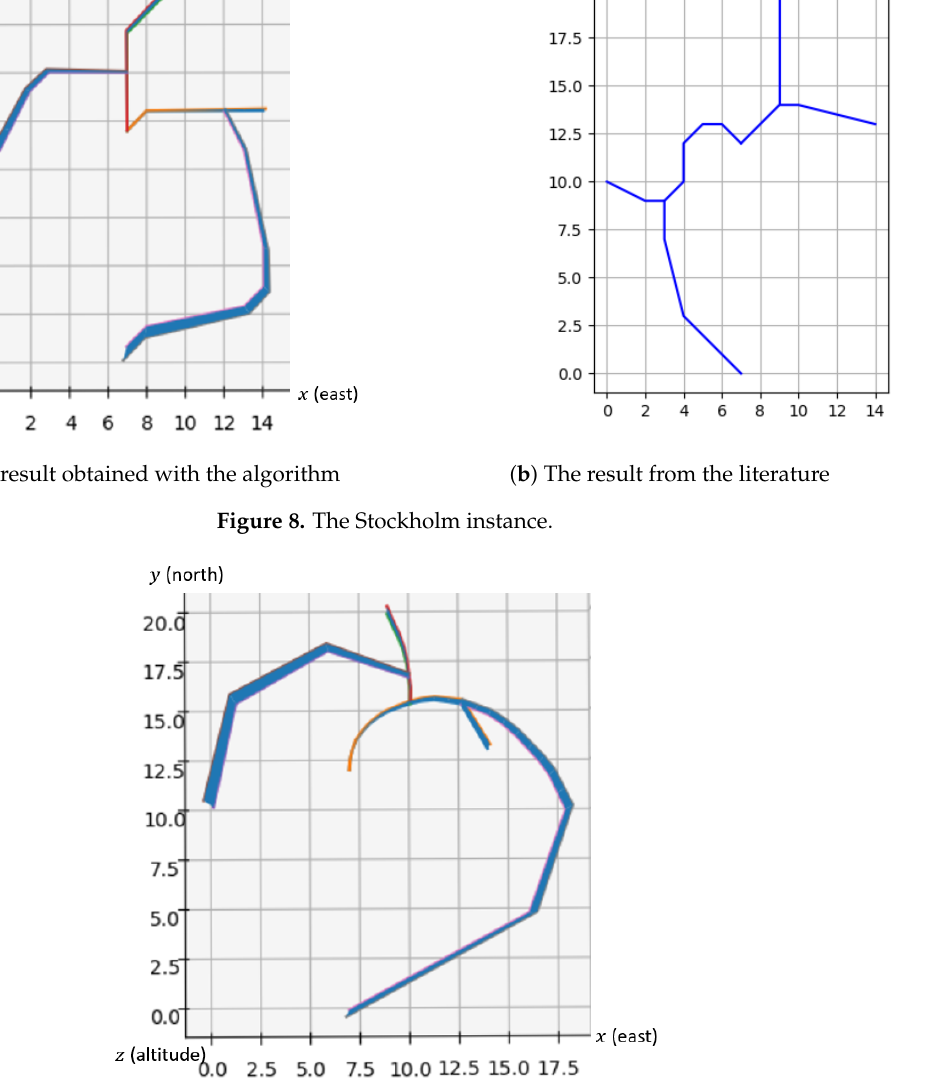
Figure 9. The result of the algorithm on the Stockholm instance by using circular layers.